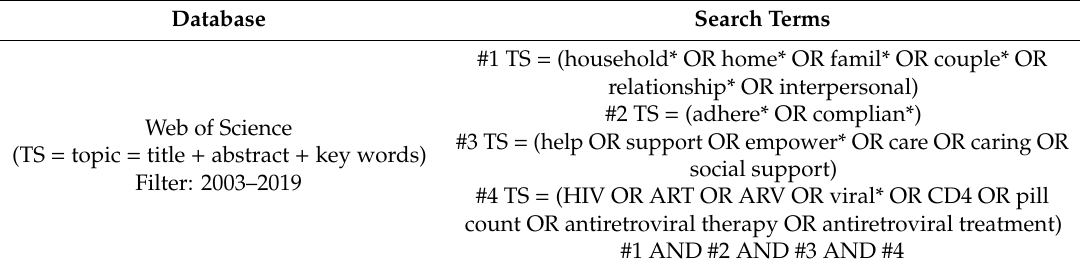
Table 1. Search terms for web of science .